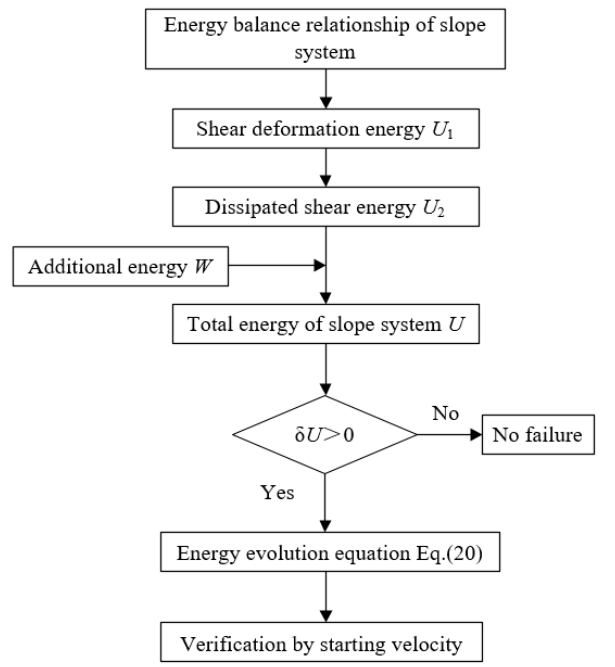
Figure 4. Flow chart for evaluation of slope stability by energy method.